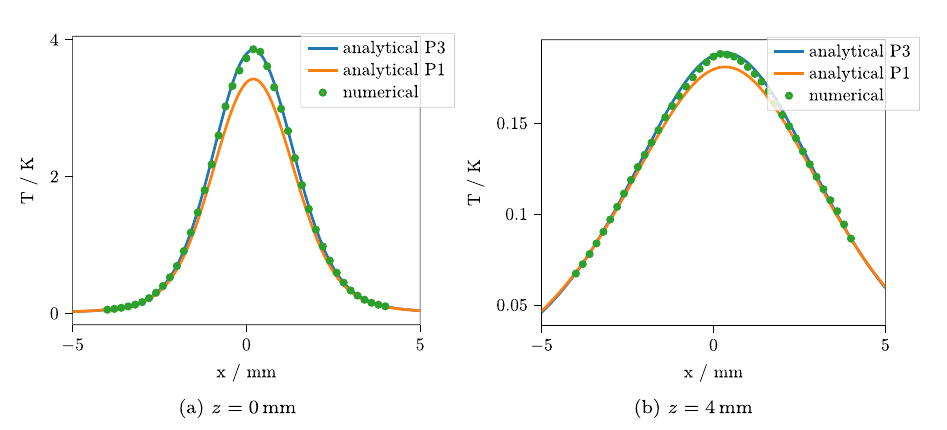
0 for two different 60 ◦ along the line y = =